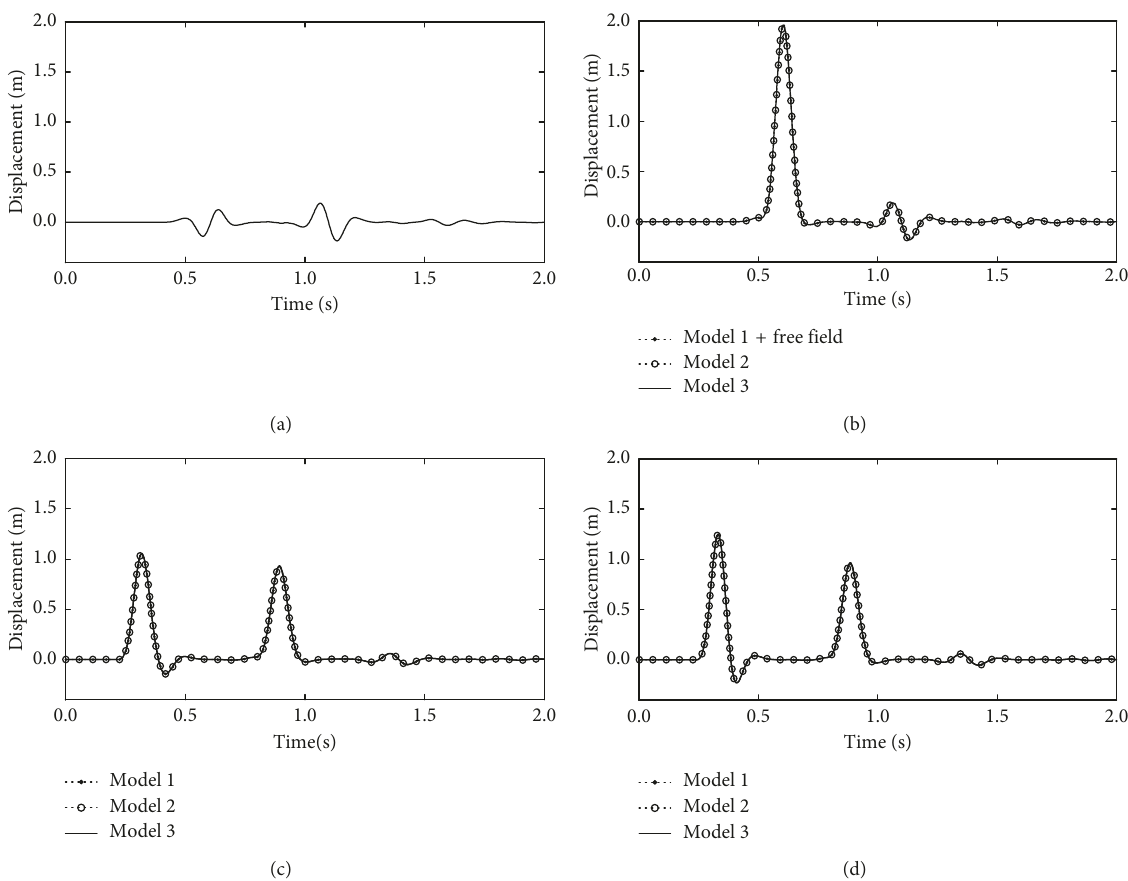
Figure 5: Displacements of the homogeneous half-space model with an underground cavity: (a) Point A (calculated by model 1), (b) Point A, (c) Point B, and (d) Point